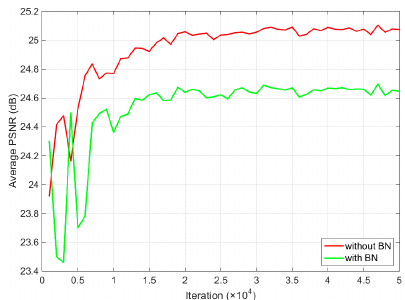
Figure 13. The simulated SAR image despeckling results of the two specific models with/without batch normalization (BN). The two specific models were trained with one-look images in the same environment, and the results were evaluated for the Set14 [43] dataset.